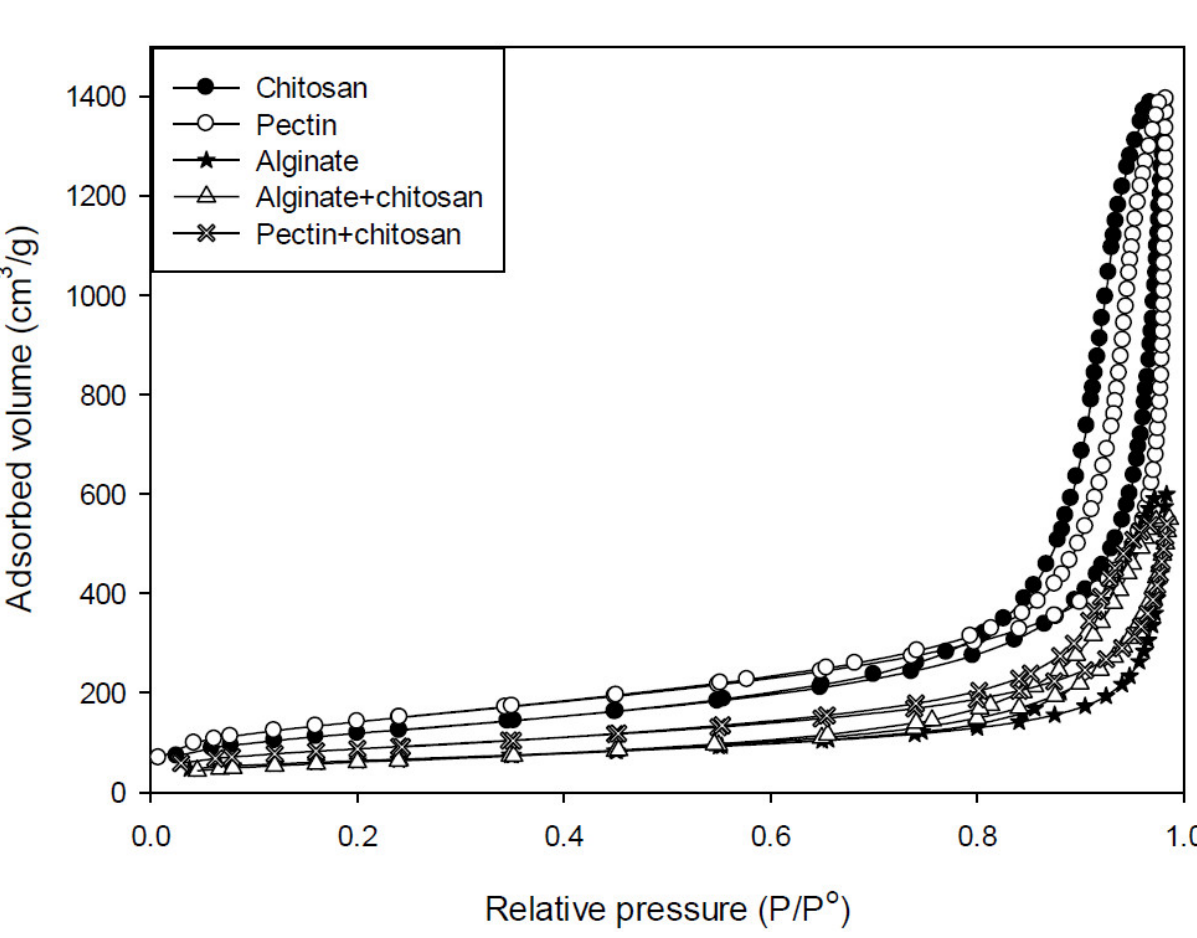
Figure 2. Adsorption isotherms of pectin, alginate, chitosan, and their composites.